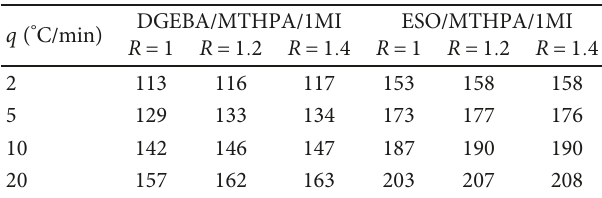
Table 1: Peak reaction temperatures ( T DGEBA/MTHPA/1MI and ESO/MTHPA/1MI with di ff erent stoichiometric ratios R .